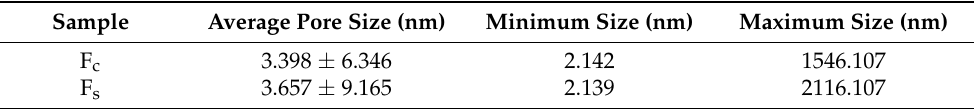
Figure 5. Scanning electron micrographs of the cross-section of cellulose aerogel fibers after regeneration in isopropanol and sCO 2 drying (6 wt.% cellulose content). ( a ) cross-section of F c (scale bar 150 µ m), ( b ) randomly oriented nanofibrils in F c (scale bar 5 µ m), ( c ) cellulose fibrils of F c (scale bar 500 nm), ( d ) cross-section of F s (scale bar 150 µ m), ( e ) dense and randomly arranged nanofibril in F s (scale bar 5 µ m), ( f ) cellulose fibrils of F s (scale bar 500 nm). The pore size distribution of F c ( g ) and F s ( h ) was acquired by image analysis using Image J software; the analyses showed that more than 60% of the pore sizes were under 5 nm for both fibers. Table 2. The pore size diameter analysis of F c and F s obtained from SEM image processing using Image J